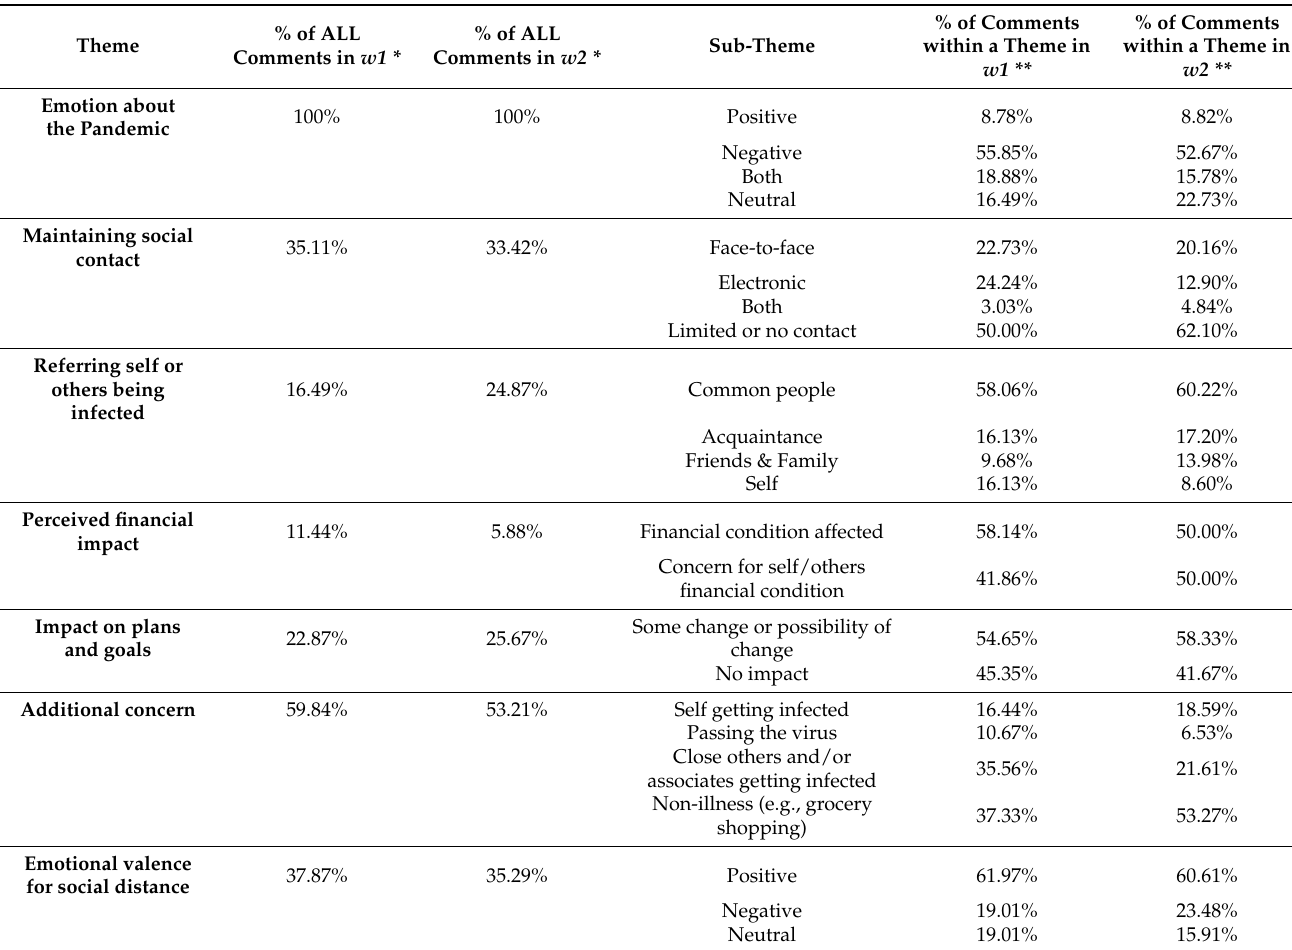
Table A1. Percentage of each theme and its sub-theme for first wave (w1 = 375 responses) and second wave (w2 = 374